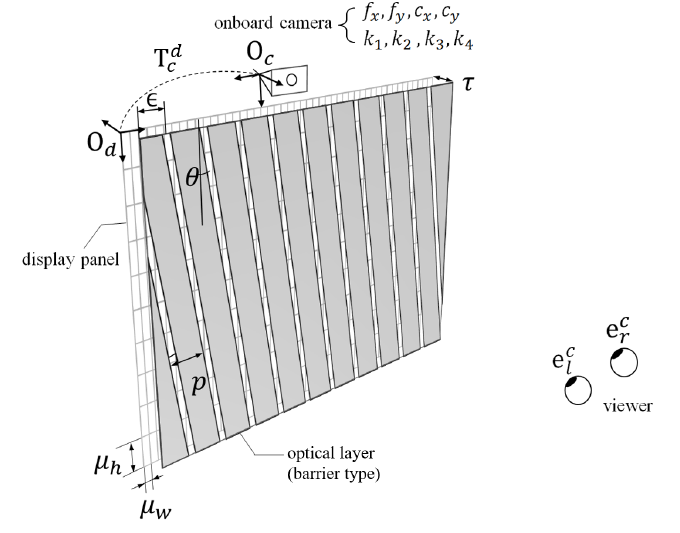
Figure 1. Parameters of an Eye-Tracked Autostereoscopic Display